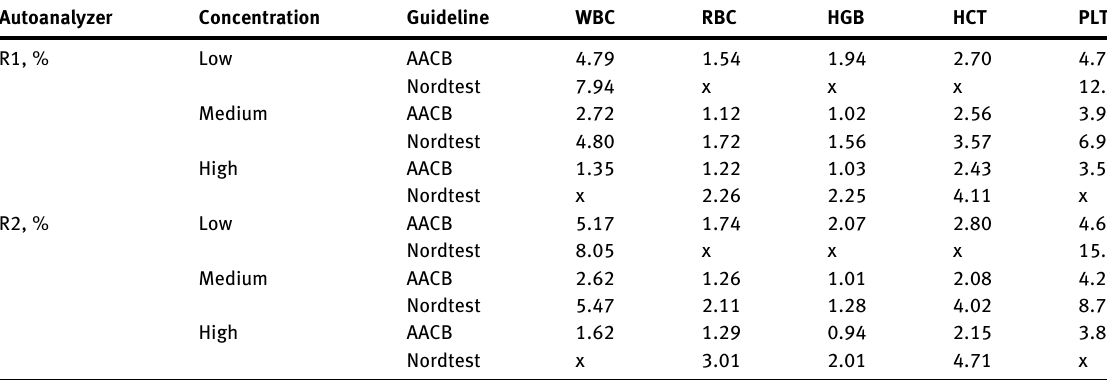
Table  : Beckman Coulter LH-  Complete Blood Count Autoanalyzer measurement uncertainty percentages. Autoanalyzer